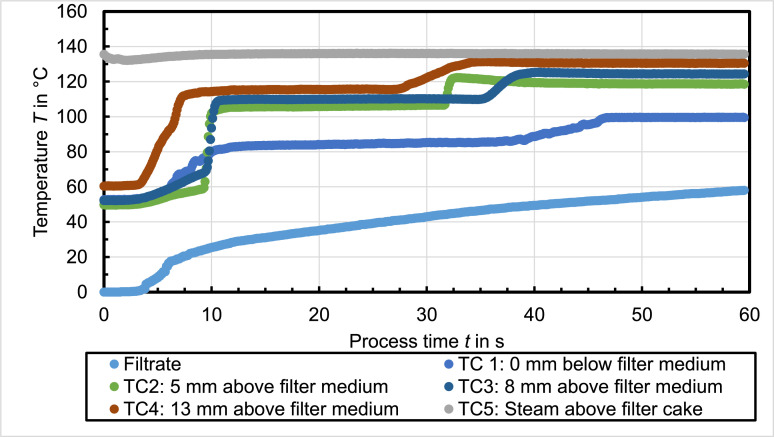
Celite®512 & toluene (Δp = 2.4 bar, Tst = 138°C, hFC = 20 mm); RM = 16 %, rC = 9 × 1012 1/m²